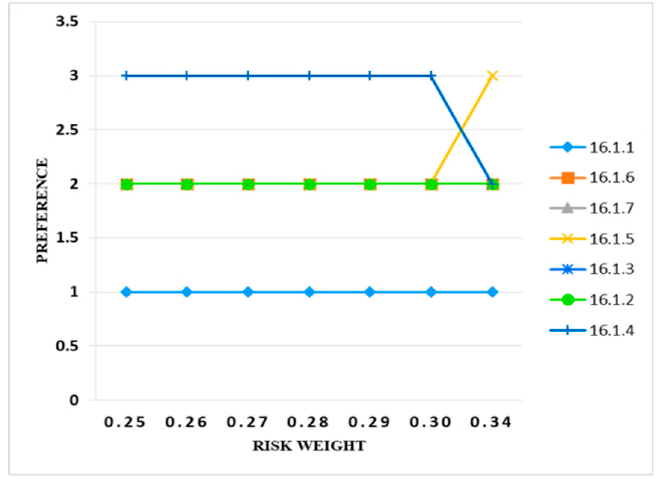
Figure 12. Sensitivity analysis of preference and risk weight.